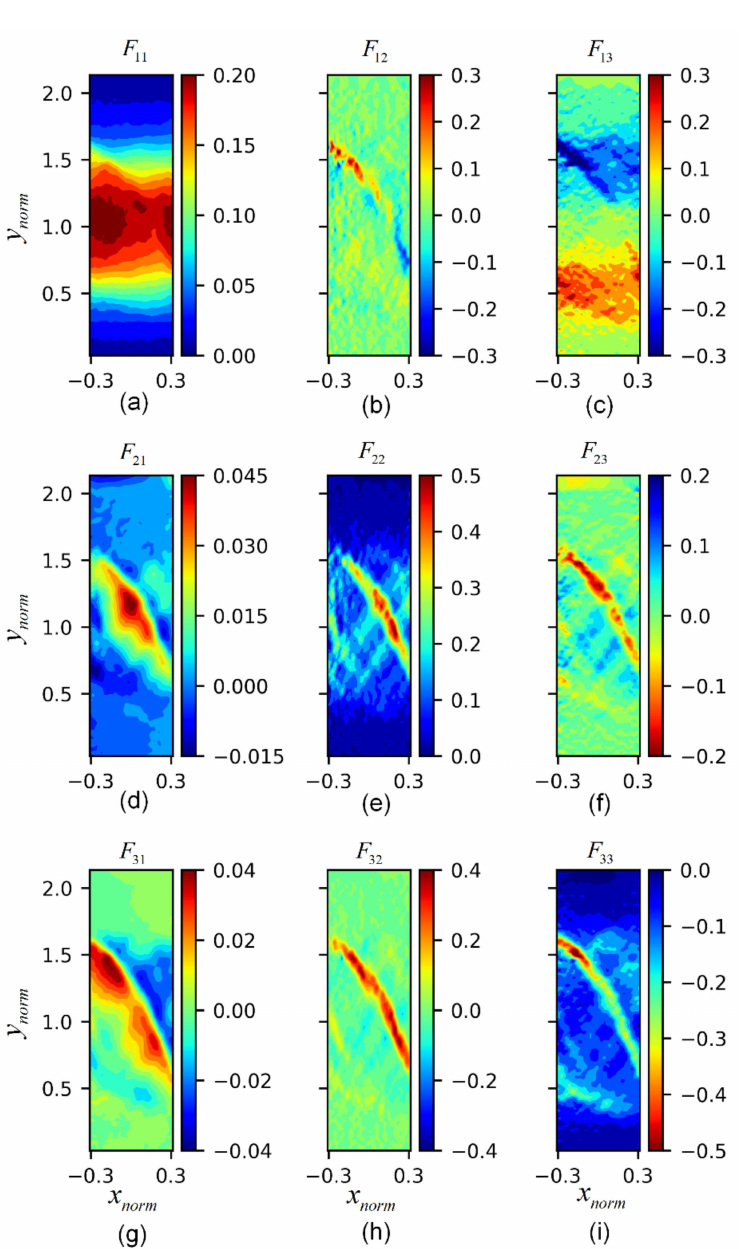
Figure 4. Nine components of gradient deformation tensor F based on test 092903b from undeformed stage to loading level of ε a = 9.6%: ( a ) tenor component F 11 ; ( b ) tenor component F 12 ; ( c ) tenor component F 13 ; ( d ) tenor component F 21 ; ( e ) tenor component F 22 ; ( f ) tenor component F 23 ; ( g ) tenor component F 31 ; ( h ) tenor component F 32 ; ( i ) tenor component F 33